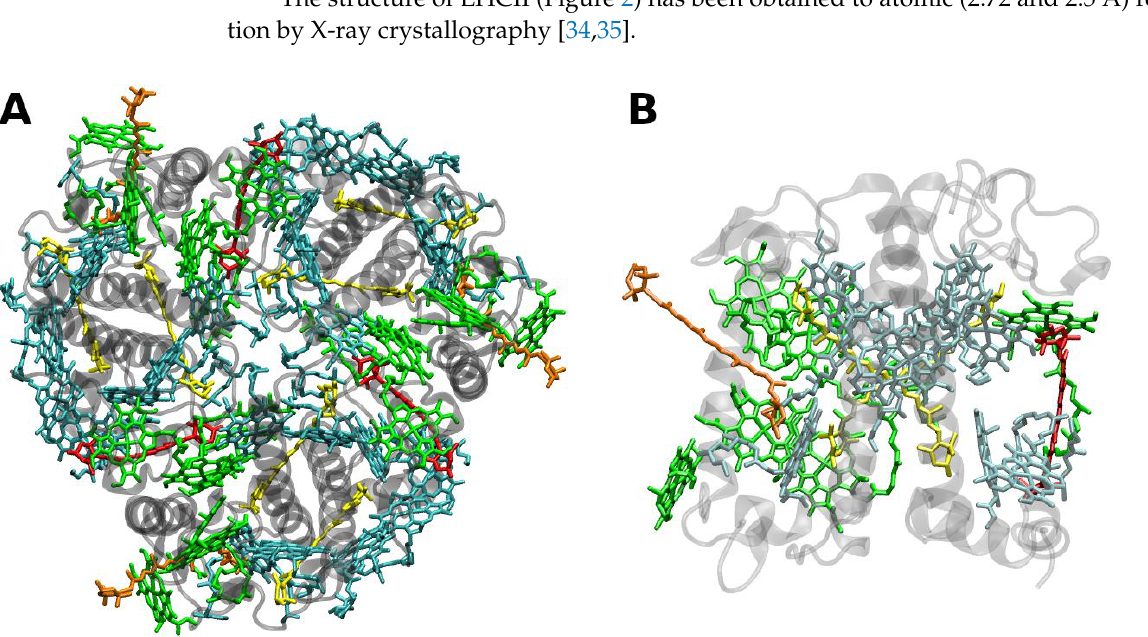
Figure 2. ( A ) Structure of trimeric main light-harvesting complex (LHC II) of plants at 2.5 Å resolution, PDB entry 2BHW [35]. Top view with regard to the thylakoid membrane plane, from the stromal side. ( B ) Monomeric subunit. The protein backbone consisting of three transmembrane α-helical domains is shown in grey. The monomeric subunit noncovalently binds 8 chlorophylls a and 6 chlorophylls b (shown in cyan and green, respectively) as well as two luteins (yellow), one neoxanthin (orange) and one violaxanthin (red). The binding site of the latter may also be occupied by its de-epoxidation products, antheraxanthin or zeaxanthin.